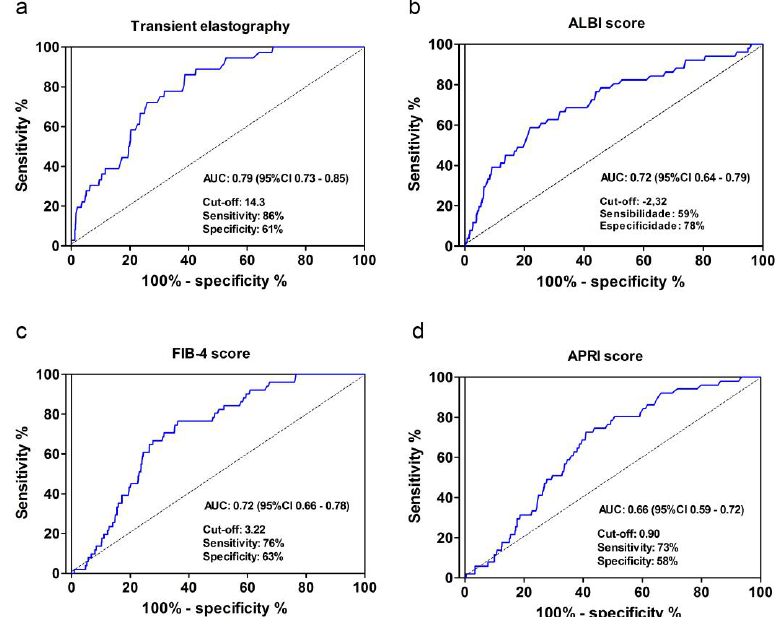
Figure 4. ROC curves of TE value ( a ), ALBI ( b ), FIB–4 ( c ) and APRI ( d ) before DAA treatment as predictors of the development of HCC. AUC: Area under the curve. ROC: receiver operating characteristic; TE: transient elastography; ALBI: albumin-bilirubin; FIB-4: fibrosis-4 index; APRI: aspartate aminotransferase to platelet ratio index; DAA: direct-acting antiviral agent; HCC: hepatocellular carcinoma.